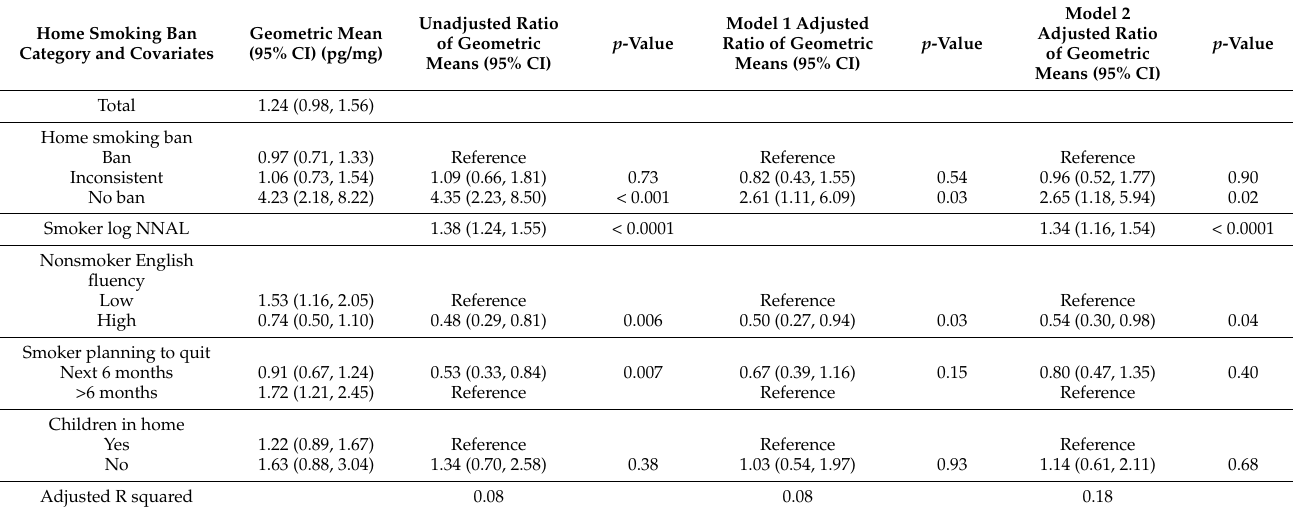
Table 3. Nonsmoker NNAL geometric mean and ratio of geometric means by home smoking ban category. Home Smoking Ban Category and